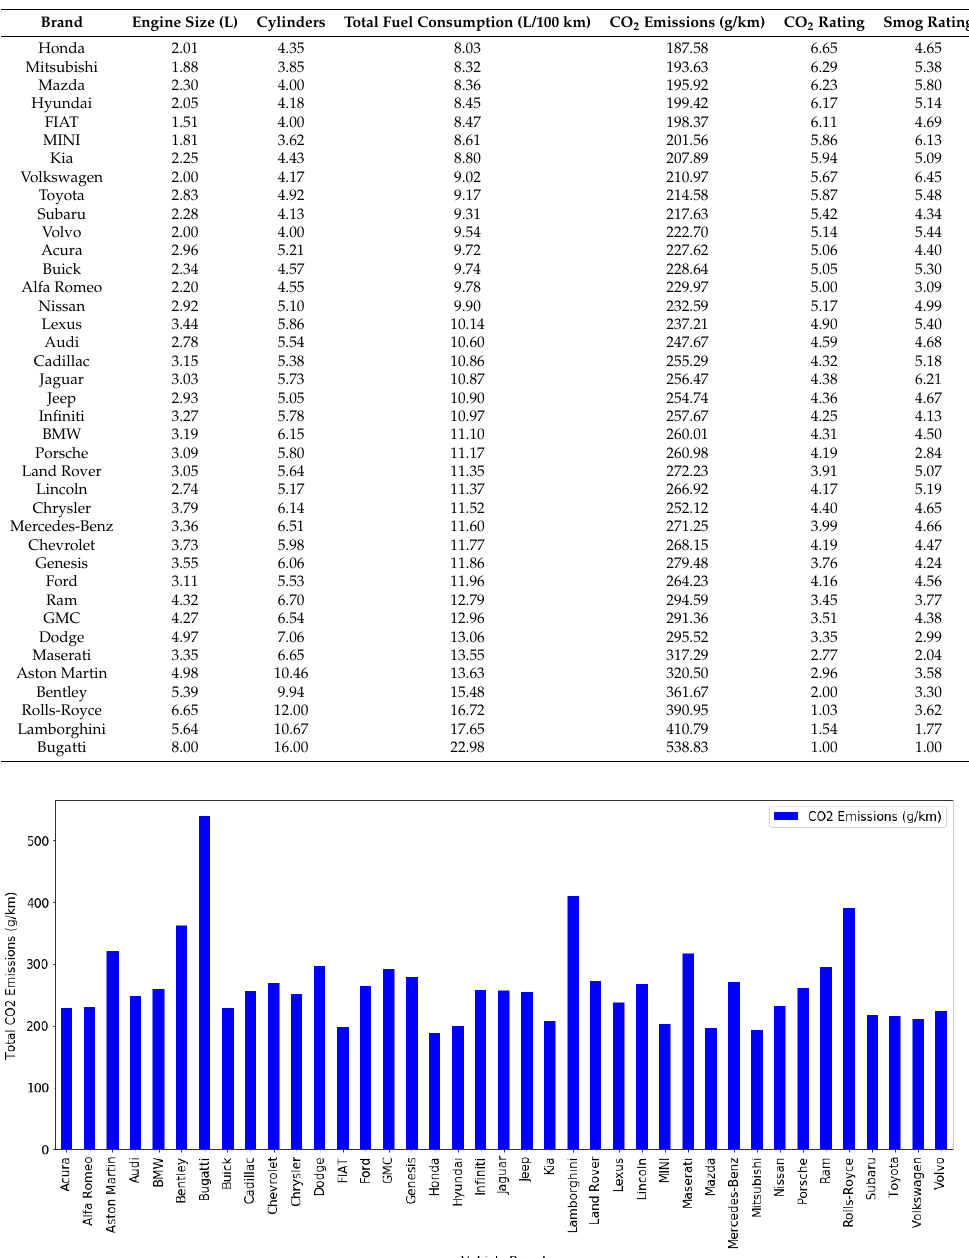
Table 2. Average data of different vehicle brands.